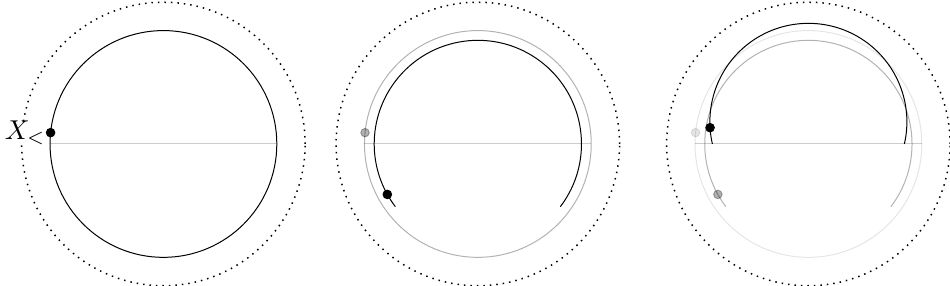
Figure 2. Illustration of the geometrical approach to the (cid:12)rst size moment computation. In the (cid:12)rst panel, we show the (cid:22) = 0 location of the point X < , which will lie on the (cid:12)rst segment of the (cid:22) > 0 solution. In this coordinate, it lies at some (cid:18) 0 < (cid:25) . We indicate the location of the point corresponding to X < with a dark dot, and show its previous location in a lighter color. Throughout, we show only the top segment of the (cid:22) = 0 saddle. A line of points at (cid:18) = 0 ; (cid:25) is drawn for reference. 6 In the second panel, we use a coordinate so that the segment X < lies on is centered at r = 0. The boundary time is an a(cid:14)ne parameter for the saddle point solution, so X < now lies at angle (cid:18) 1 = (cid:21) (cid:18) 0 . (cid:25) In the last panel, we have changed to the more symmetric coordinate of the third panel of (cid:12)gure 1 by the boost (A.9). Note that we can approximate the (cid:12)rst move of X < by a rotation,